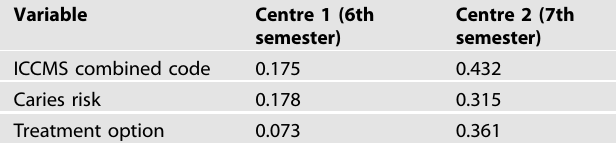
Table 2. Mean simple kappa values for concordance between the responses of students in each centre and the